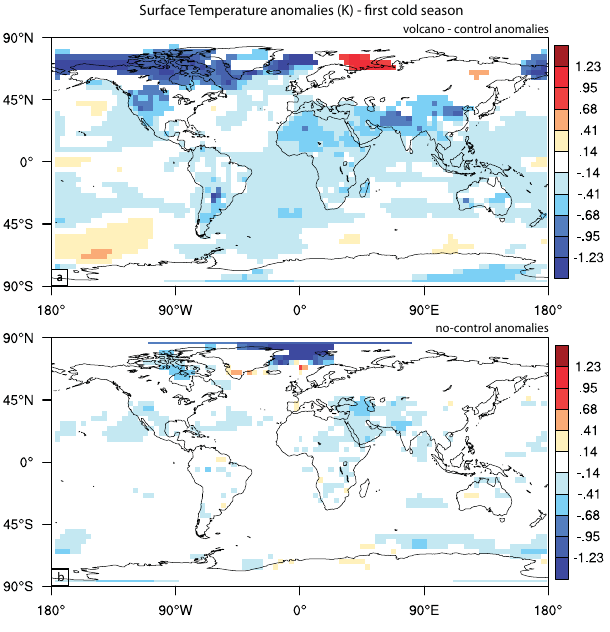
Fig. 4. Modeled precipitation anomalies during the period Oc- tober 1991–September 1992. Both anomalies using the volcano– control method (a) and the no-control method (b) are plotted here where significant at the 90% level. Warmer colors indicate dry